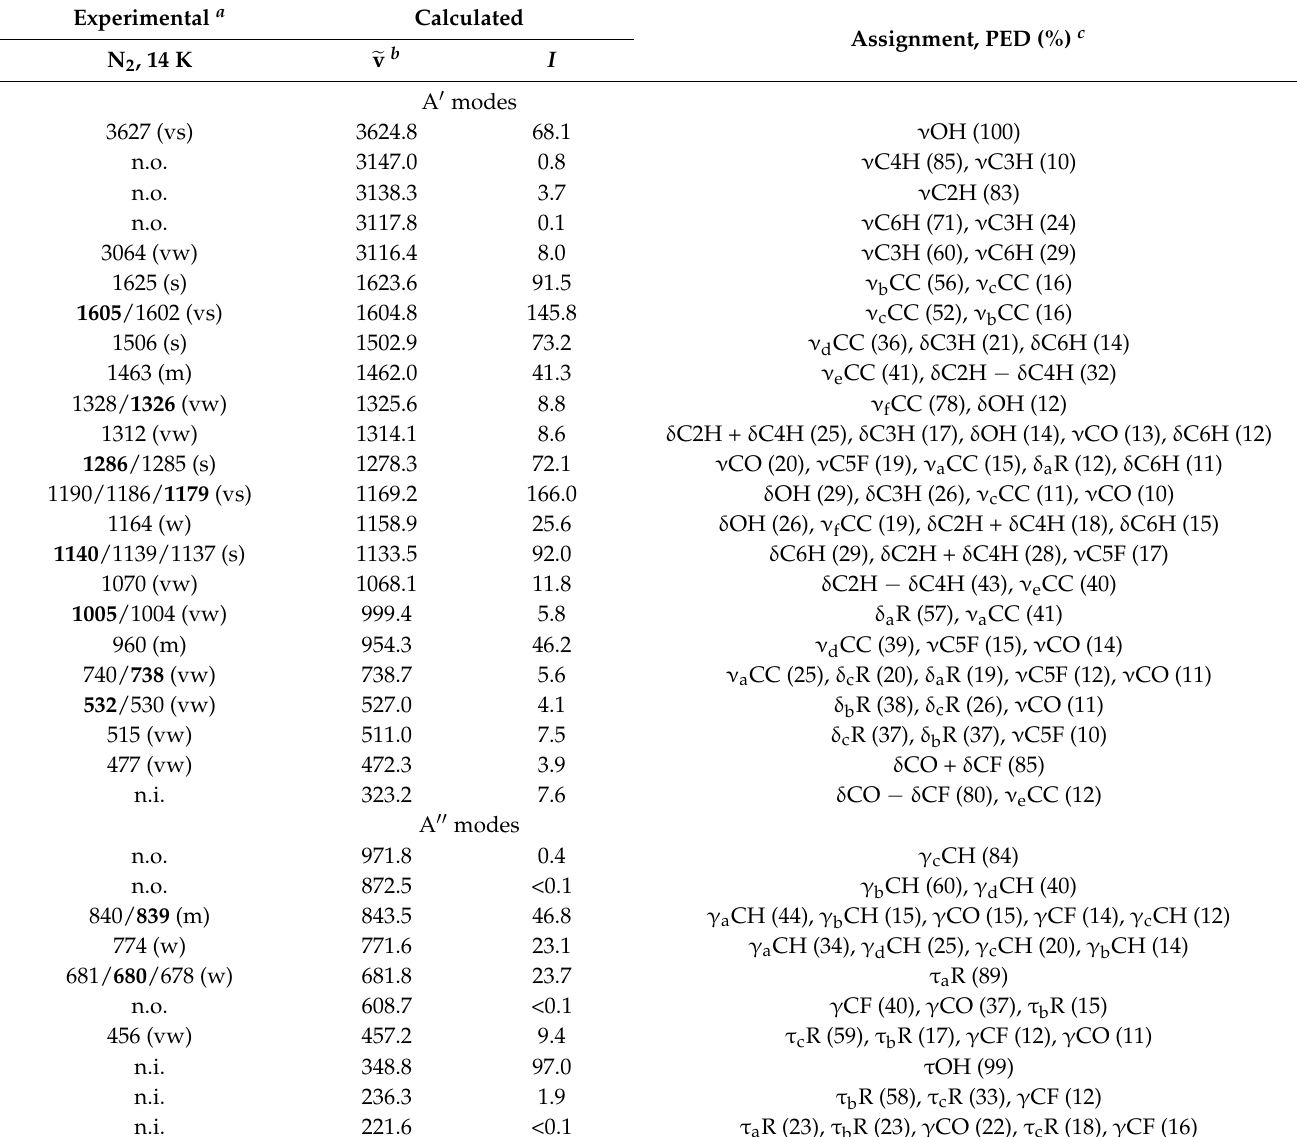
Table 3. Bands observed in the IR spectrum of m FP isolated in nitrogen (N 2 ), compared with the harmonic wavenumbers ( (cid:101) v/cm − 1 ), absolute intensities ( I /km mol − 1 ), and potential energy distribution (PED, %) calculated for the cis conformer of m FP at the B3LYP/aug-cc-pVTZ level of